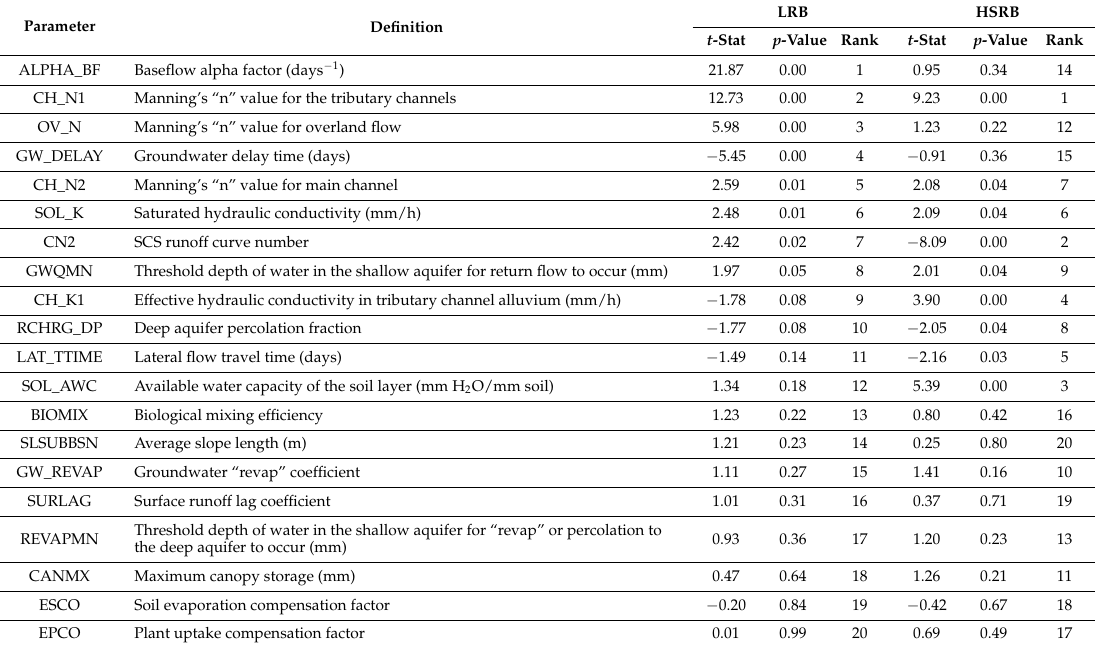
Table 5. Sensitivity analysis of SWAT model parameters for LRB and